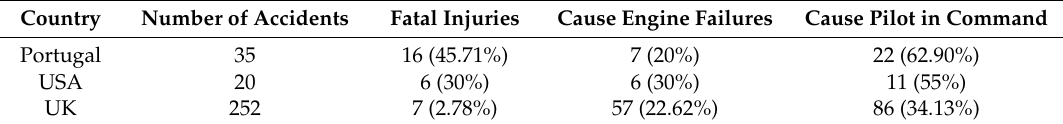
Table 3. Accident cause and injury